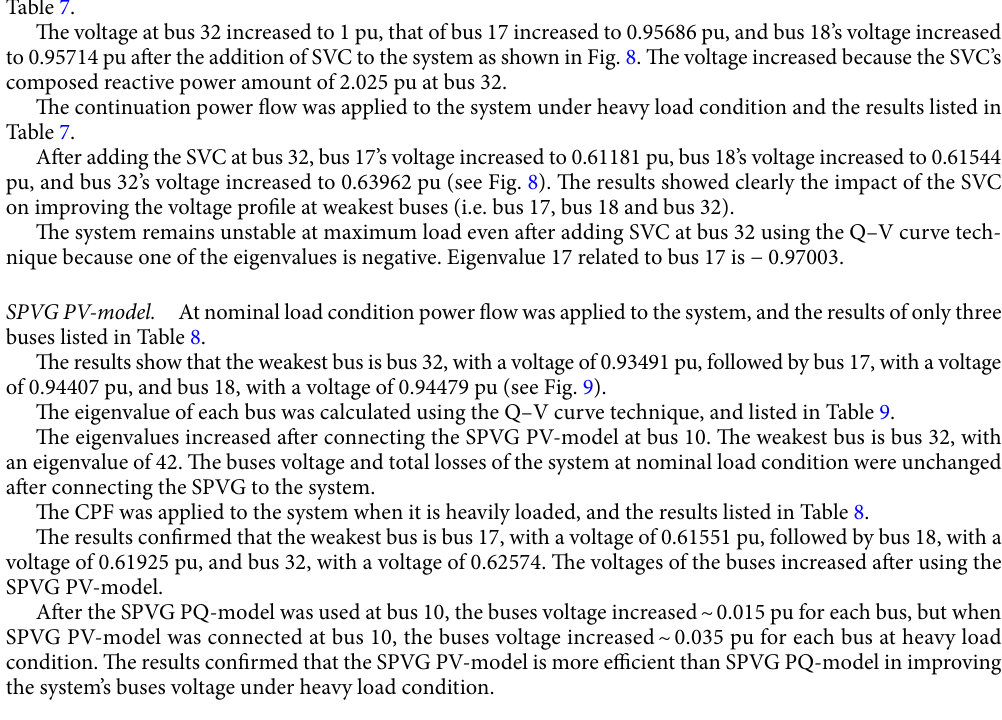
Table 7. After adding the SVC at bus 32, bus 17’s voltage increased to 0.61181 pu, bus 18’s voltage increased to 0.61544